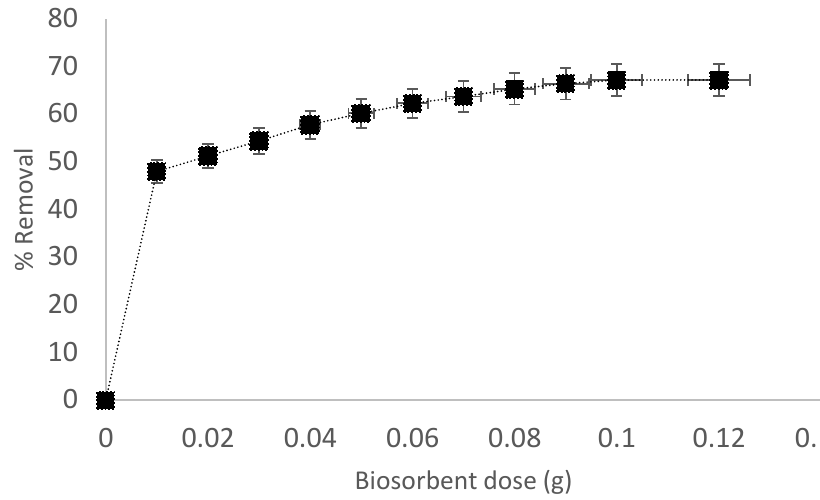
Figure 5. Effect of biosorbent dosage on biosorption process.